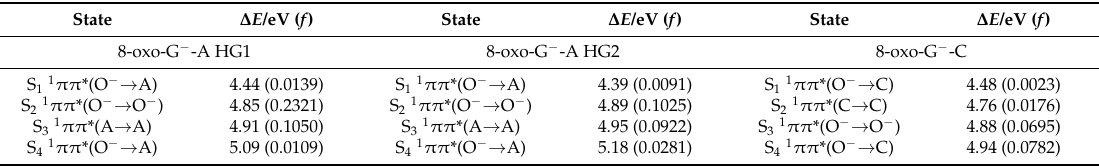
Table 1. Vertical excitation energies ( ∆ E ) and oscillator strengths ( f ) of the lowest four excited states of the two 8-oxo-G − -A HG base pairs and the 8-oxo-G − -C base pair, calculated at the ADC(2)/cc-pVDZ level of theory. Here O − stands for 8-oxo-G −